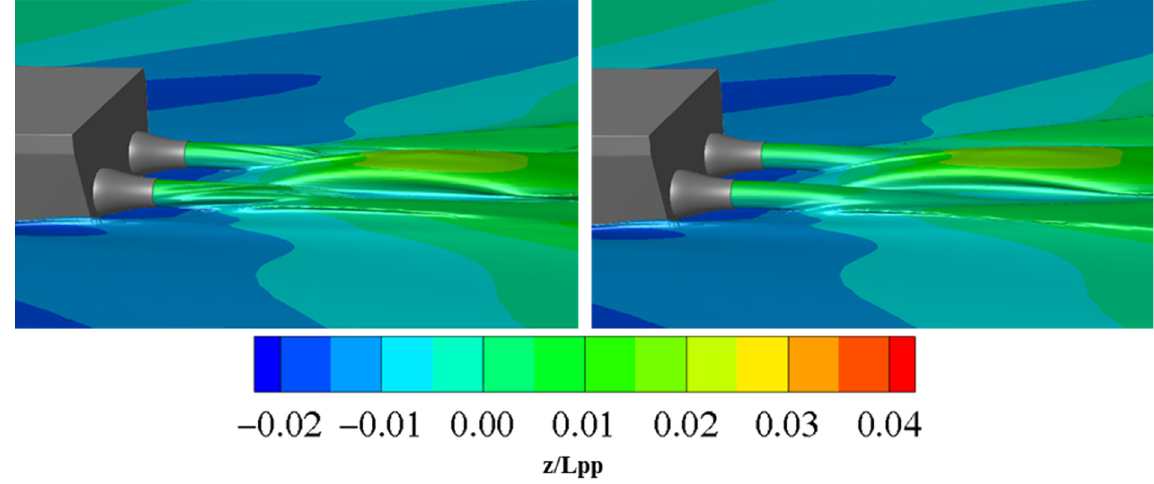
Figure 12. Jet stream with the MRF model and body-force model (BFM).